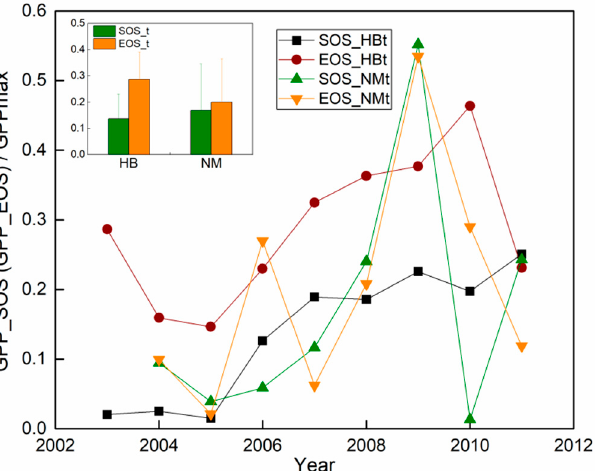
Figure 8. Interannual dynamics of vegetation carbon phenological period thresholds (%) in HB and NM grasslands from 2003 to 2011. The inset chart shows the mean values of annual vegetation carbon phenological period thresholds in HB and NM, and the green and yellow bars represent the SOS and EOS of the year in HB and in NM grasslands, respectively.